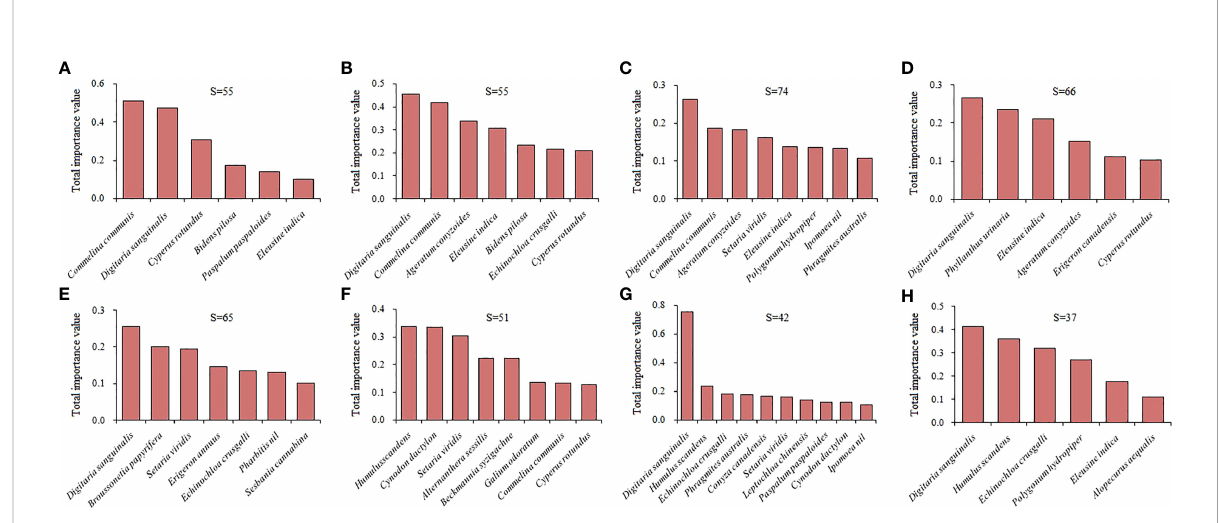
FIGURE 3 Variations in the dominant accompanying plant species of the A . philoxeroides communities among different latitudinal clusters in terrestrial habitats. S values represent the total number of accompanying plant species in the A . philoxeroides- invaded communities along each latitudinal cluster. (A – H) represent the 1 to 8 latitudinal clusters, respectively. The same is as